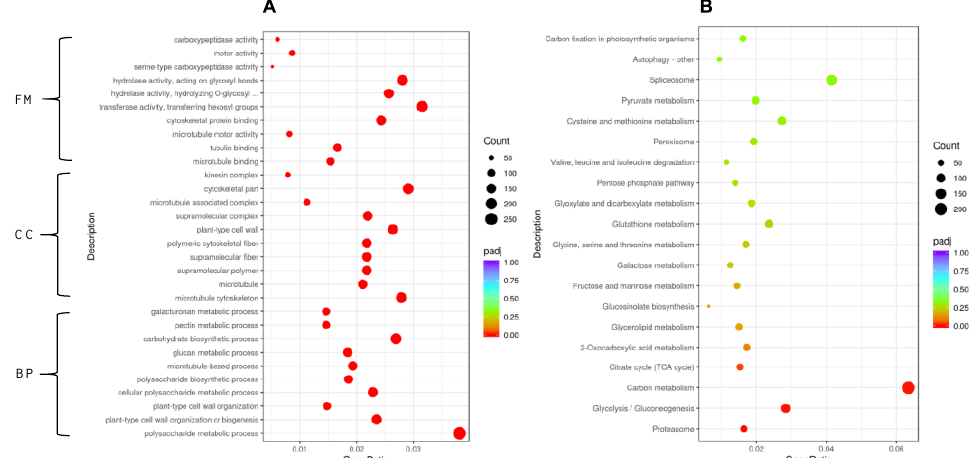
Figure 10. RNA sequencing analysis of A. thaliana treated by APD-II-15 . ( A ) GO analysis of differential expression genes (MF: molecular function; CC: cell component; BP: biological process); ( B ) KEGG analysis of differential expression genes.